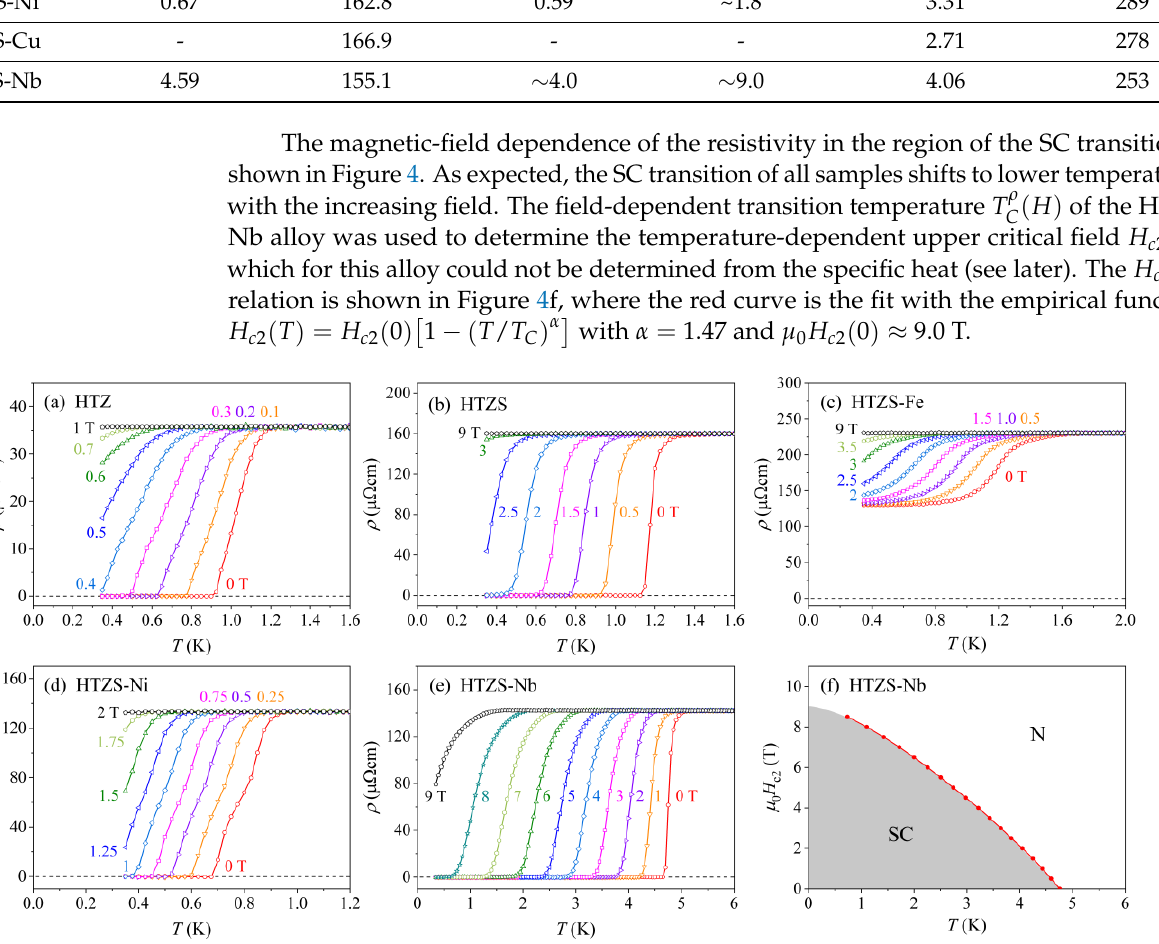
and the ρ 300K resistivity) C